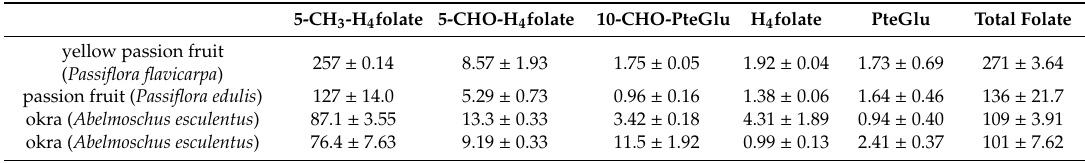
PteGlu Total Folate